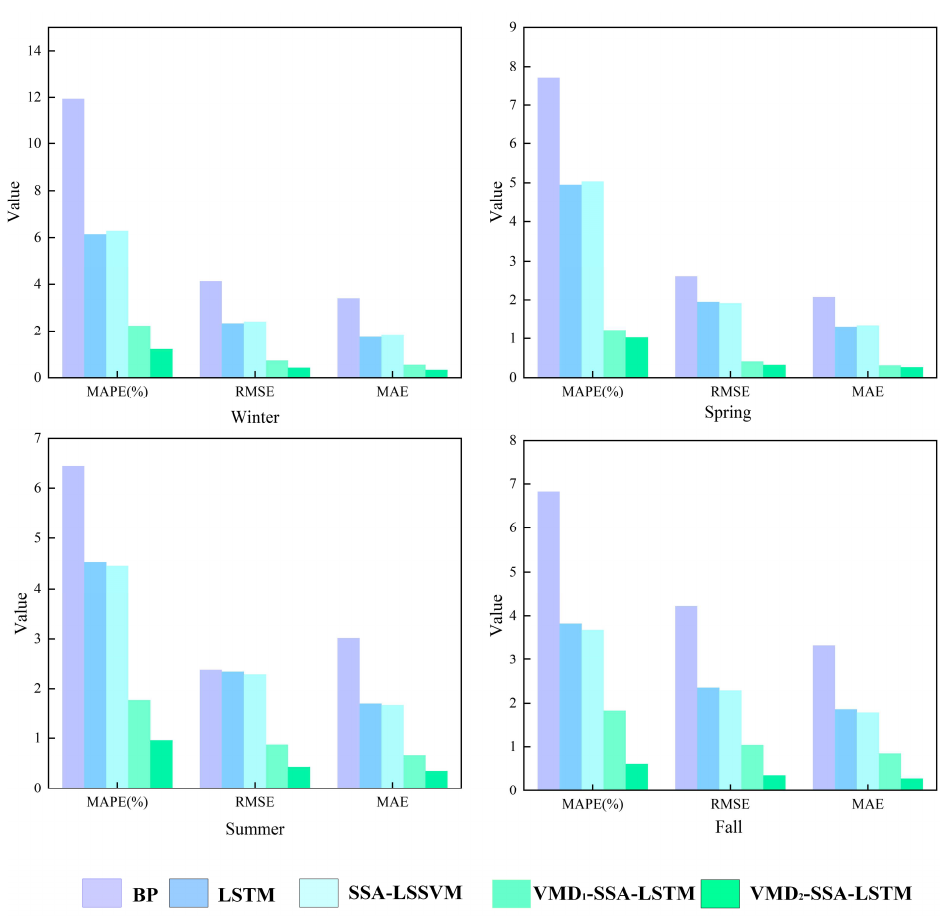
Figure 13. Spanish forecast error indicators. Table 3. Error metrics for different prediction models in Spain.